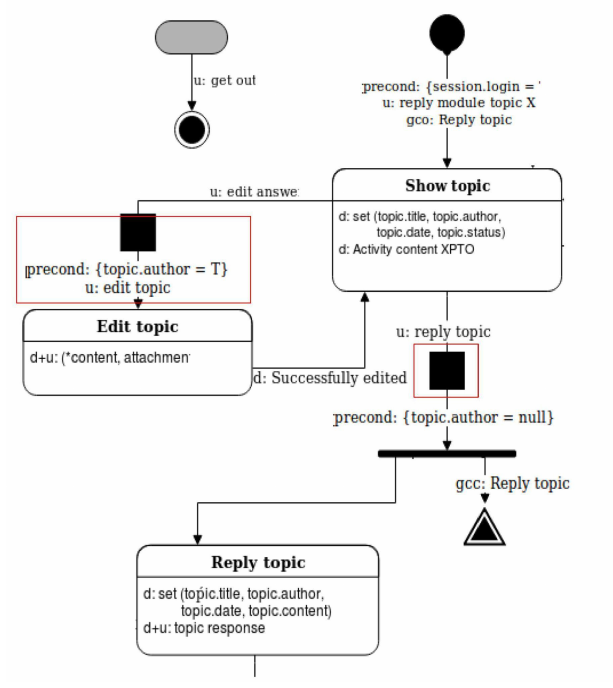
Figure 5. Diagram forum